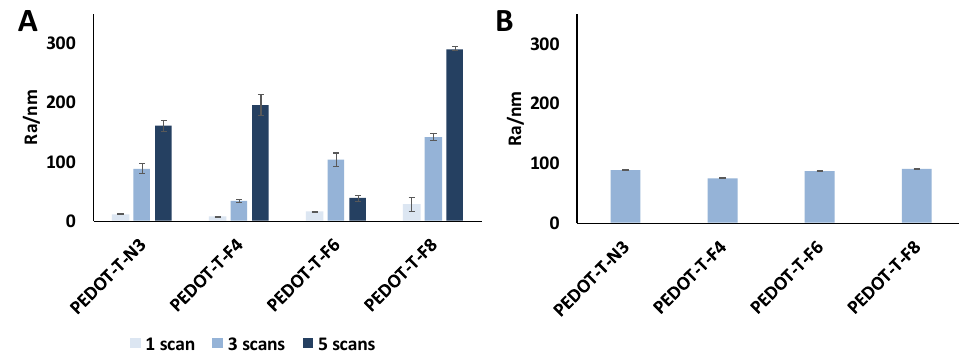
Figure 4. Roughness measurement for surfaces elaborated with ante strategy ( A ) and post strategy ( B ). The bars on the columns illustrate the standard deviations of the measurements.